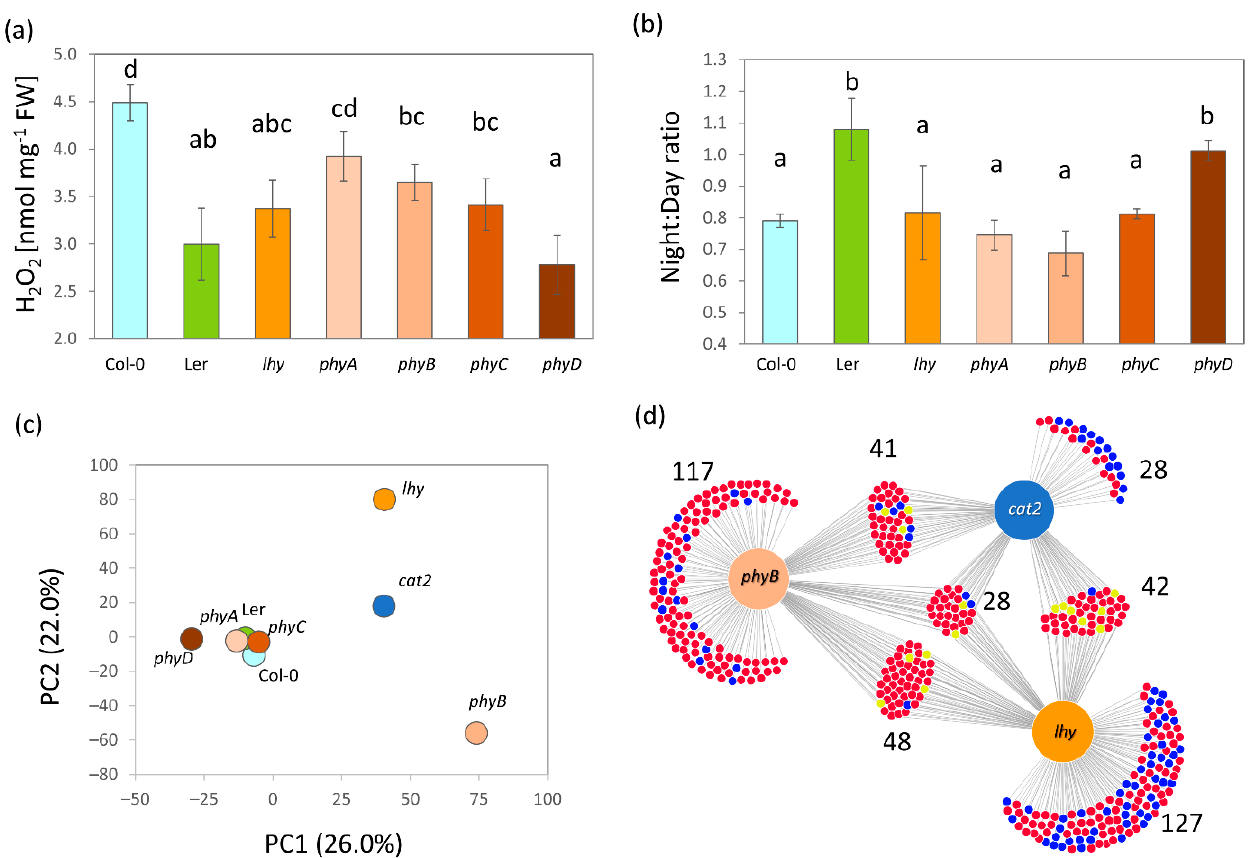
Figure 7. Variation in hydrogen peroxide content and effects of the catalase 2 mutation on the night–day regulation of plant proteome. ( a ) The hydrogen peroxide pool in the middle of the day and ( b ) the comparison of the night–day hydrogen peroxide content ratio in the analyzed mutants. The results are based on two complete replicates analyzed in duplicates; letters indicate statistically significant differences (Kruskal–Wallis, Dunn’s test, p < 0.05). ( c ) The mutation in catalase 2 showed a similarity in protein regulation to the phyB and lhy mutations. The PCA based on the identified 640 night–day regulations and ( d ) The DiVenn visualization of similarity in the observed regulations in phyB and lhy . For details, see Supplementary Table